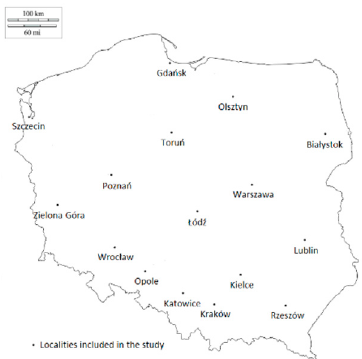
Figure 1. Distribution of the localities included in the study.